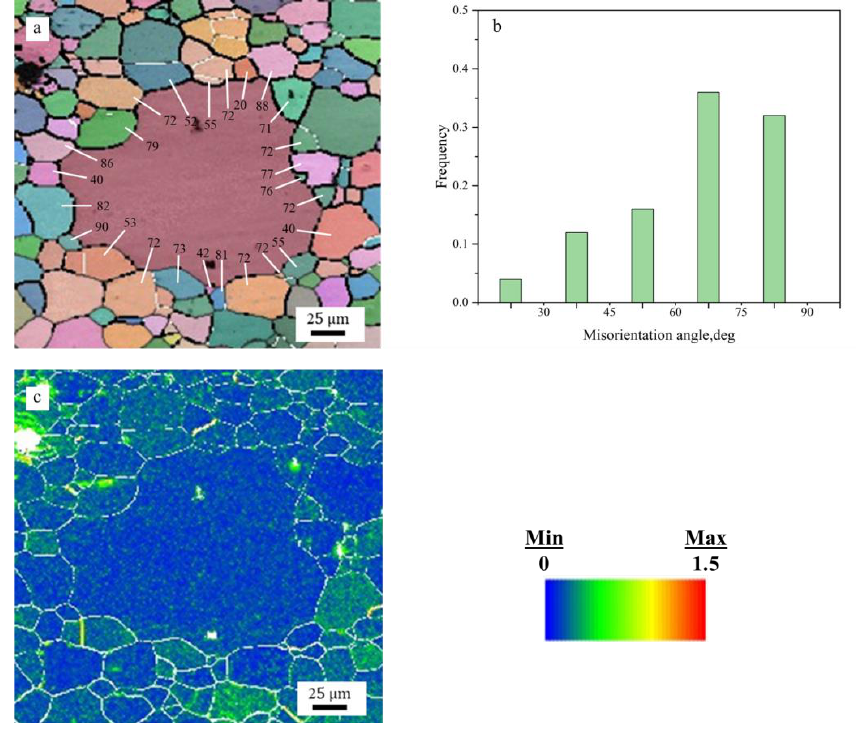
Figure 19. The microstructure and misorientation distribution of the enlarged view of the rectangular region in Figure 18. ( a ) Abnormal grains and their nearest neighbor misorientations, ( b ) histogram distribution of the misorientation between abnormal grains and their nearest adjacent grains, ( c ) KAM map. θ ≥ 15 ◦ is a high-angle grain